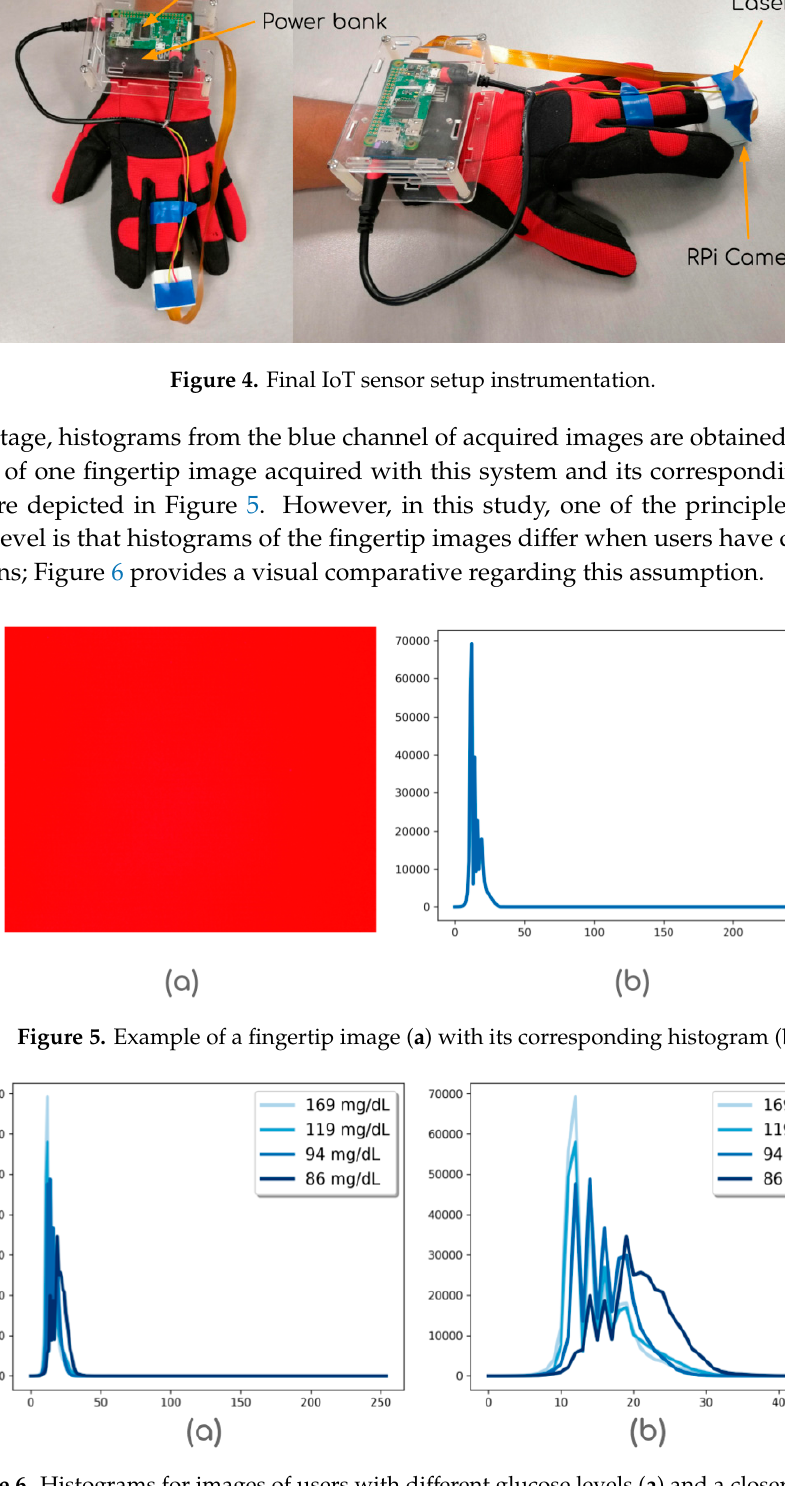
Figure 6. Histograms for images of users with different glucose levels ( a ) and a closer view ( b ).